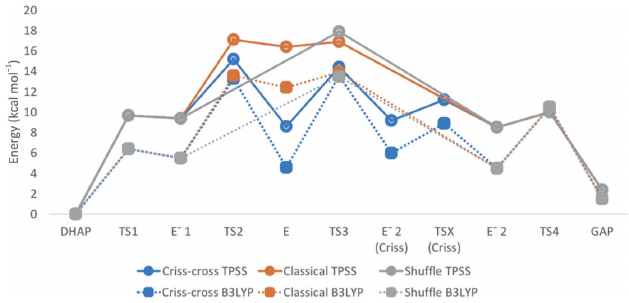
Figure 8 Reaction path of the TIM-catalyzed isomerization of DHAP to GAP calculated by QM/MM for three different mechanisms: criss-cross (blue), classical (orange) and shuffle